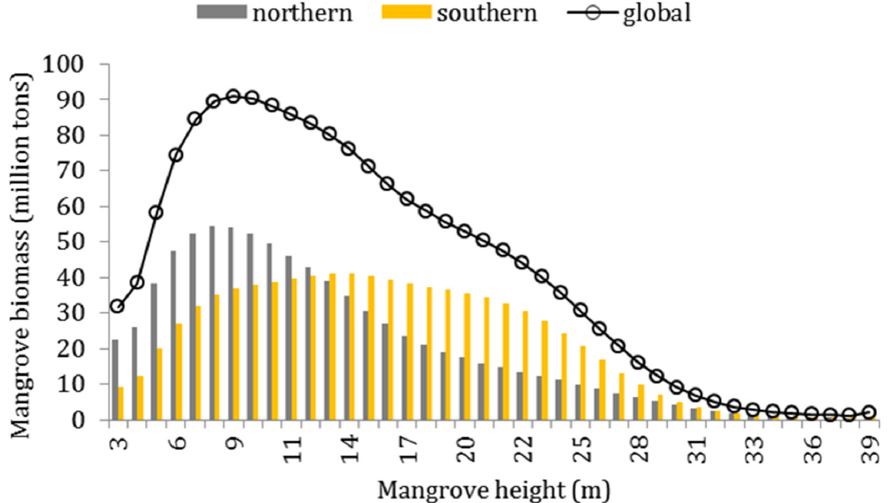
Figure 4. Biomass distribution across classes of mangrove heights for each hemisphere and the globe. The Northern Hemisphere contained a positive skew in the distribution, whereas the Southern Hemisphere contained a normal distribution. Although the Northern Hemisphere contained more mangrove areas than the Southern Hemisphere, the Southern Hemisphere had more mangrove biomass (875.5 million tons) than the Northern Hemisphere (820.8 million